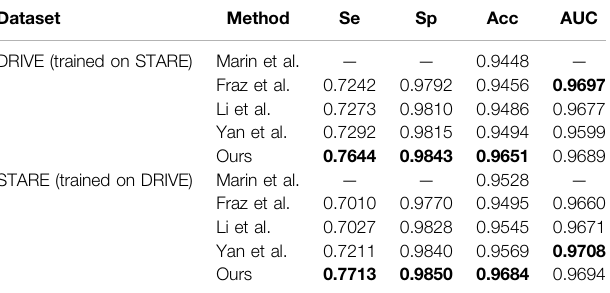
TABLE 3 | Cross-training results on DRIVE and STARE datasets. Dataset